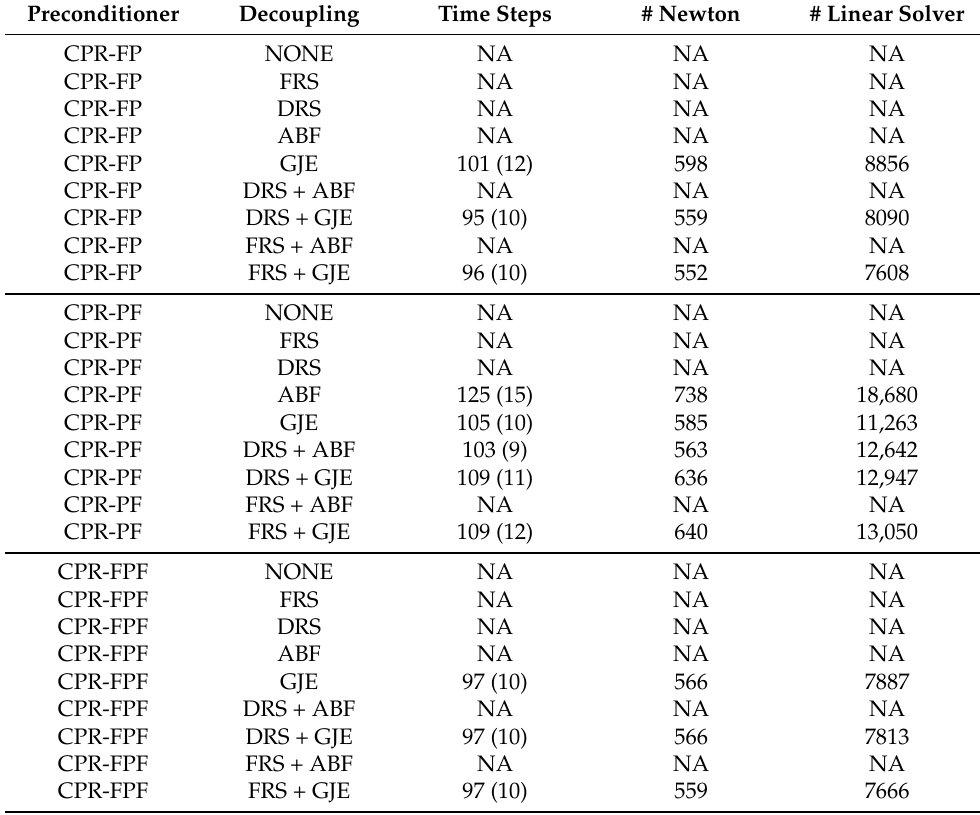
Table 11. Numerical summary of Example